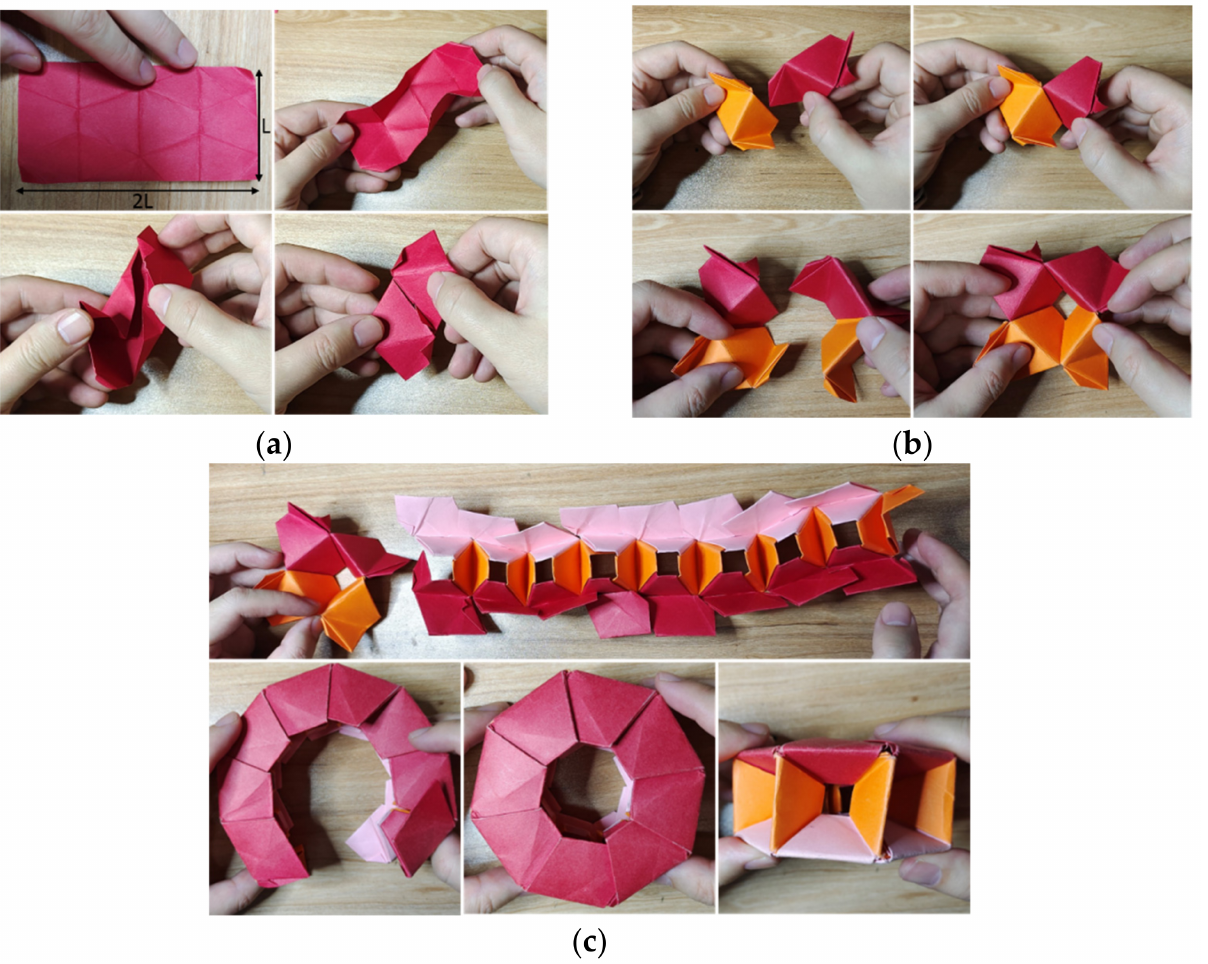
Figure 2. Assembly process of the one-layer twisted tower: ( a ) basic segment with 2 L × L paper; ( b ) assembly of two basic segments and four basic segments; ( c ) formation of the one-layer twisted